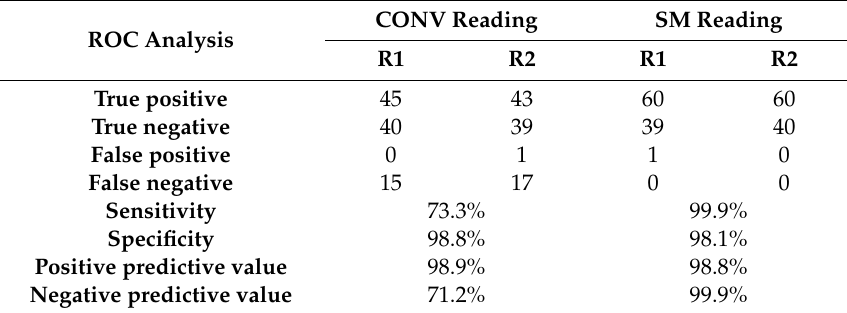
Table 3. Receiver operating characteristics (ROC)